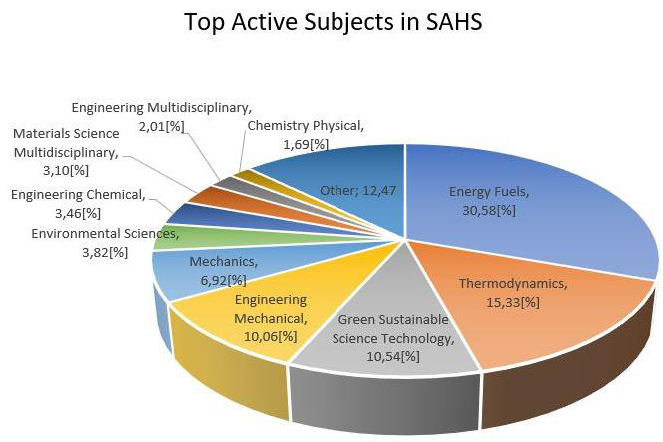
Figure 4. Top active categories in SAHs publication.